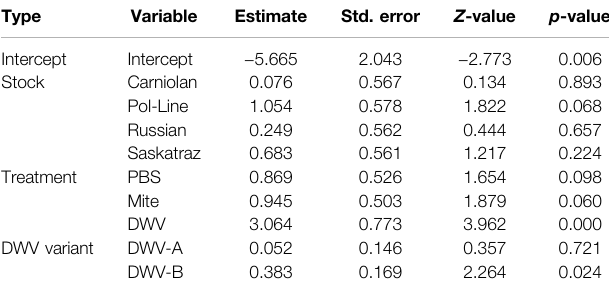
(i.e., wing deformities) ( Table 6 ). The treatment group had a signi fi cant impact on the presence of symptoms, with DWV injections (associated with increased DWV-A levels) inducing symptoms in a higher number of bees relative to all other treatment groups (compared to control: z = 3.962, p < 0.001; compared to PBS: z = 3.037, p = 0.013; compared to mite: z = 2.814, p = 0.025) ( Table 6 ). Symptomatic bees had higher DWV- A (10 9.71 ± 0.20 ) and DWV-B (10 10.14 ± 0.12 ) levels than